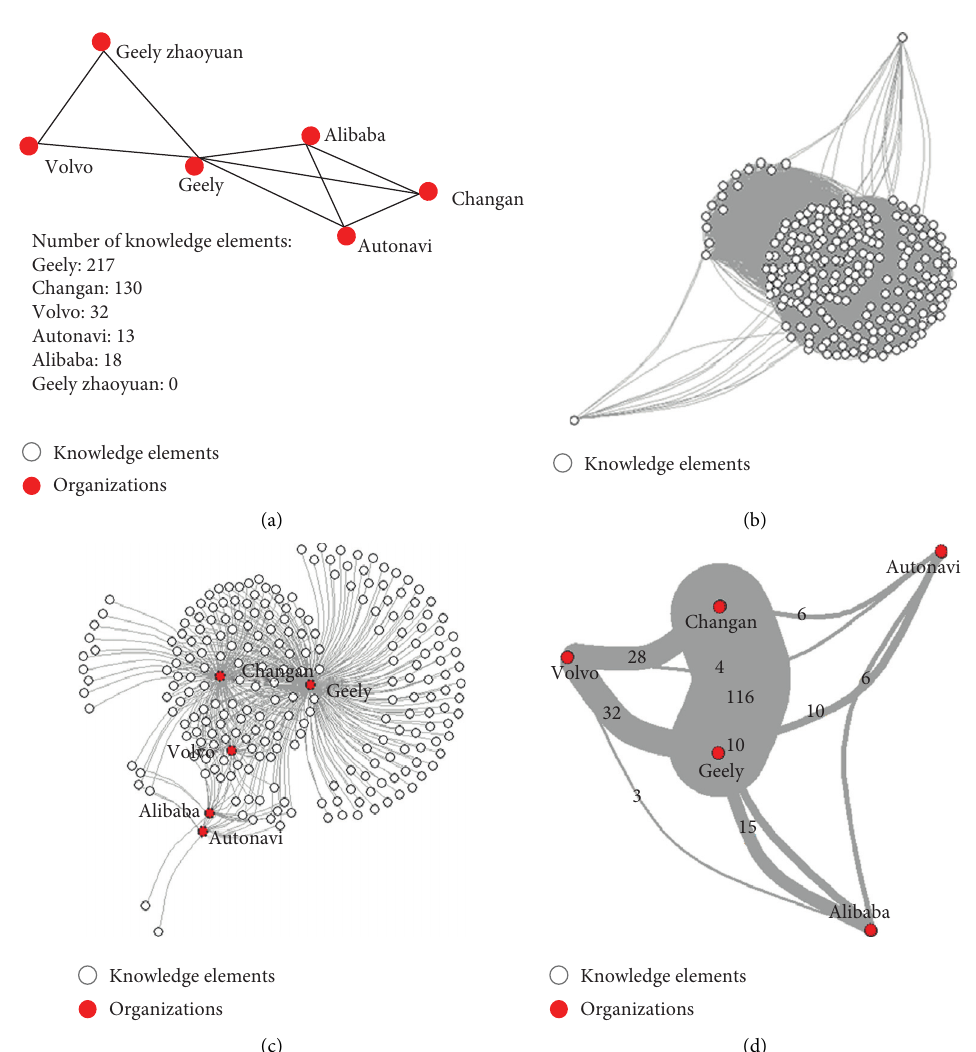
Figure 1: A case of interorganizational knowledge networks: (a) subgroup; (b) interorganizational knowledge network; (c) two-mode network; (d) weighted two-mode network, the weight is the number of same knowledge elements between two